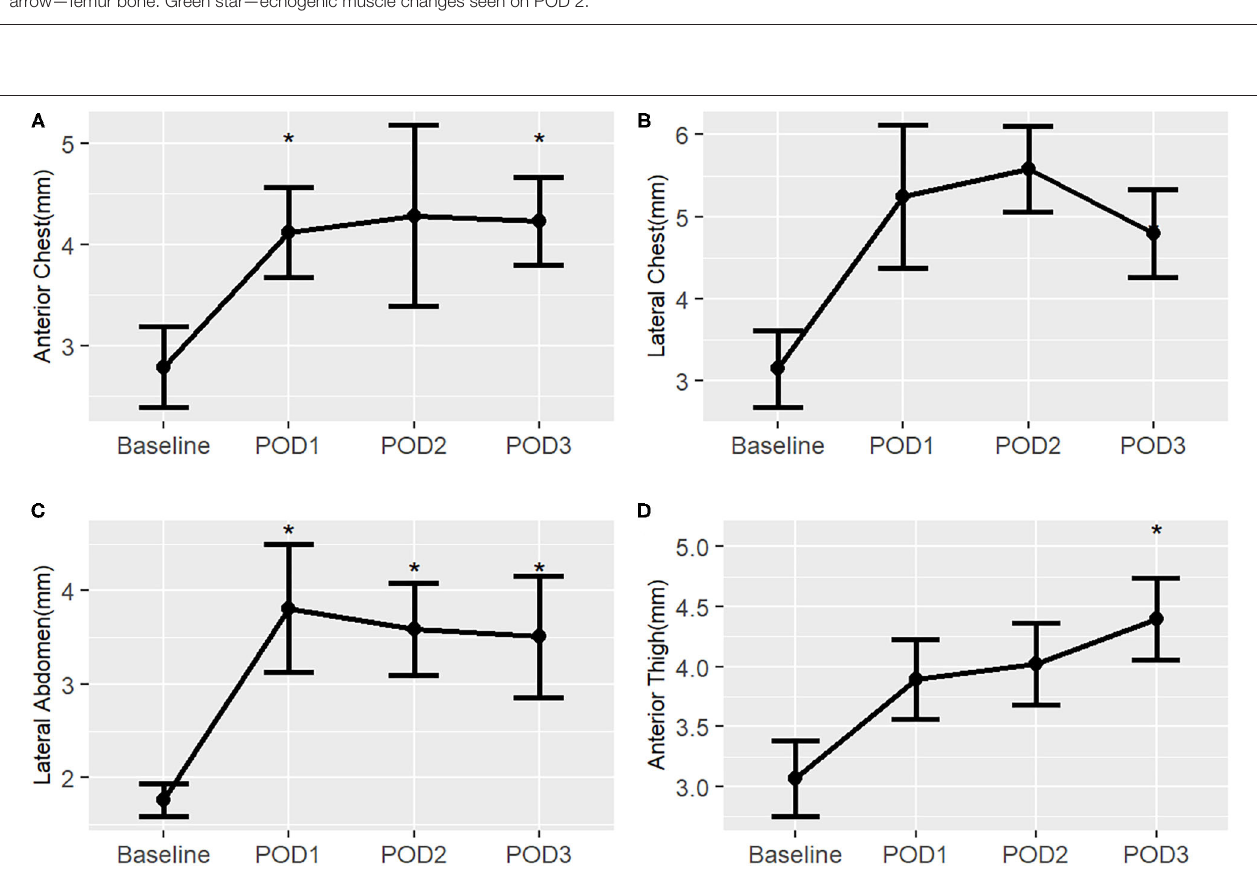
FIGURE 7 | Post-operative changes in mean subcutaneous tissue thickness from baseline of surgical neonates, by right-sided body site. *, p < 0.05. (A) Anterior chest; (B) Lateral chest; (C) Lateral abdomen; (D) Anterior thigh.